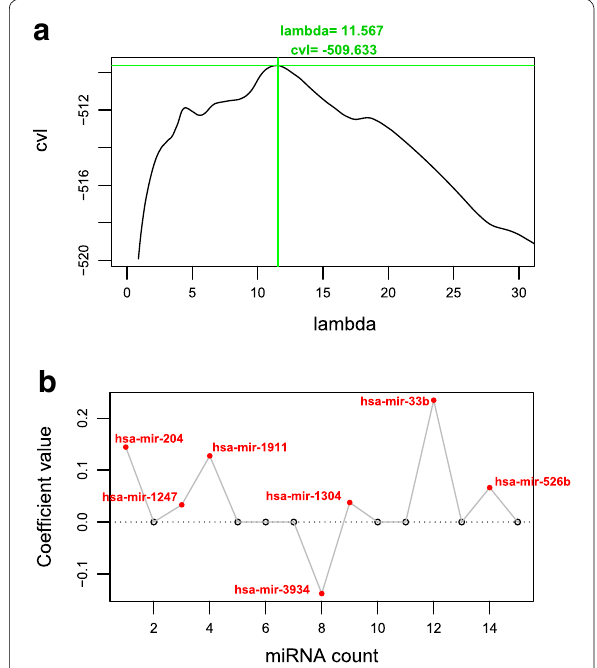
Fig. 2 a The lambda parametric curves by cross-validation likelihood (cvl) algorithm. Horizontal axis and vertical axis represent lambda and cvl, respectively; the intersection of green dotted line represent that the maximum value of cvl was -509.633 when lambda was 11.567. b